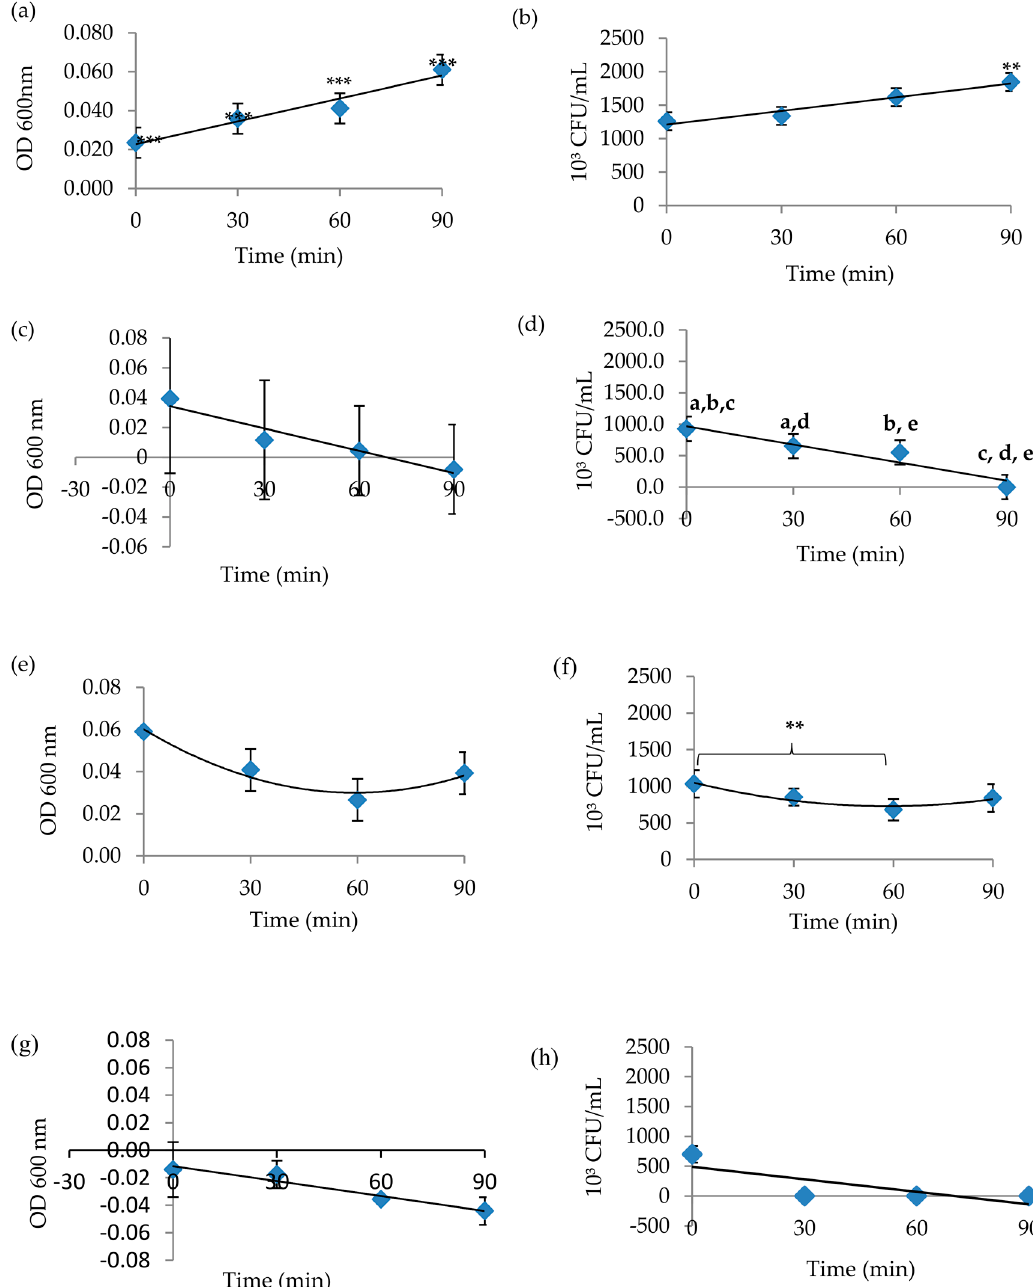
Figure 1. P. aeruginosa growth curve for the susceptibility test after exposure to 0.4 g/mL of extracts from 0 to 90 min. ( a ) control optical density (OD) values, ( b ) control viable count values, ( c ) cinnamon aqueous extract OD values, ( d ) cinnamon aqueous extract viable count values, ( e ) kaffir lime aqueous extract OD values, ( f ) kaffir lime aqueous extract viable count values, ( g ) lime juice OD values, and ( h ) lime juice viable count values. The post hoc Tukey HSD test showed that the control OD values were very significantly different from each other at all time points (*** p < 0.00), whereas the control viable count value at 90 min was significantly different from values at all other time points (** p < 0.01). The viable cell counts of P. aeruginosa exposed to the cinnamon aqueous extract differed significantly from each other at all time point (dots with same letter differ significantly, ** p < 0.01), except for time points between 30 min and 60 min. For the kaffir lime aqueous extract, viable count values at 0 min differed significantly from those at 60 min (** p < 0.01). Results were expressed in OD (600 nm) and 10³ CFU/mL, respectively, with n = 3.